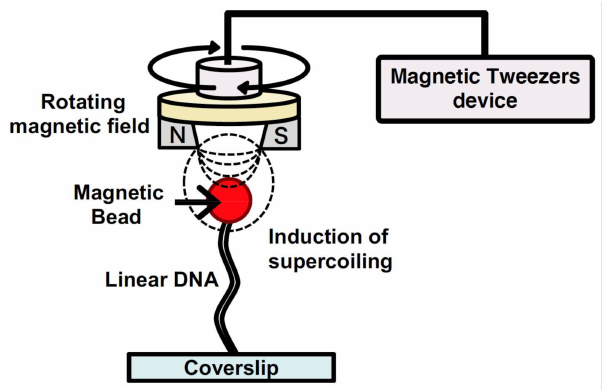
Figure 6. Induction of supercoiling in the single DNA molecules by magnetic